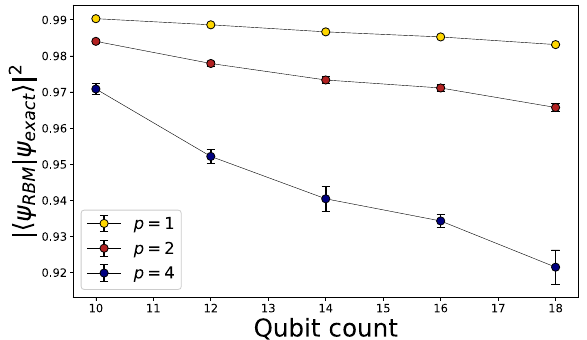
Fig. 3 Benchmarking with exact fi delities. Fidelities between approximate RBM variational states and quantum states obtained with exact simulation, for different values of p = 1, 2, 4 and number of qubits. QAOA angles γ , β we use are set to optimal values at p = 4 for each random graph instance. Ten randomly generated graphs are used for each system size. Error bars represent the standard